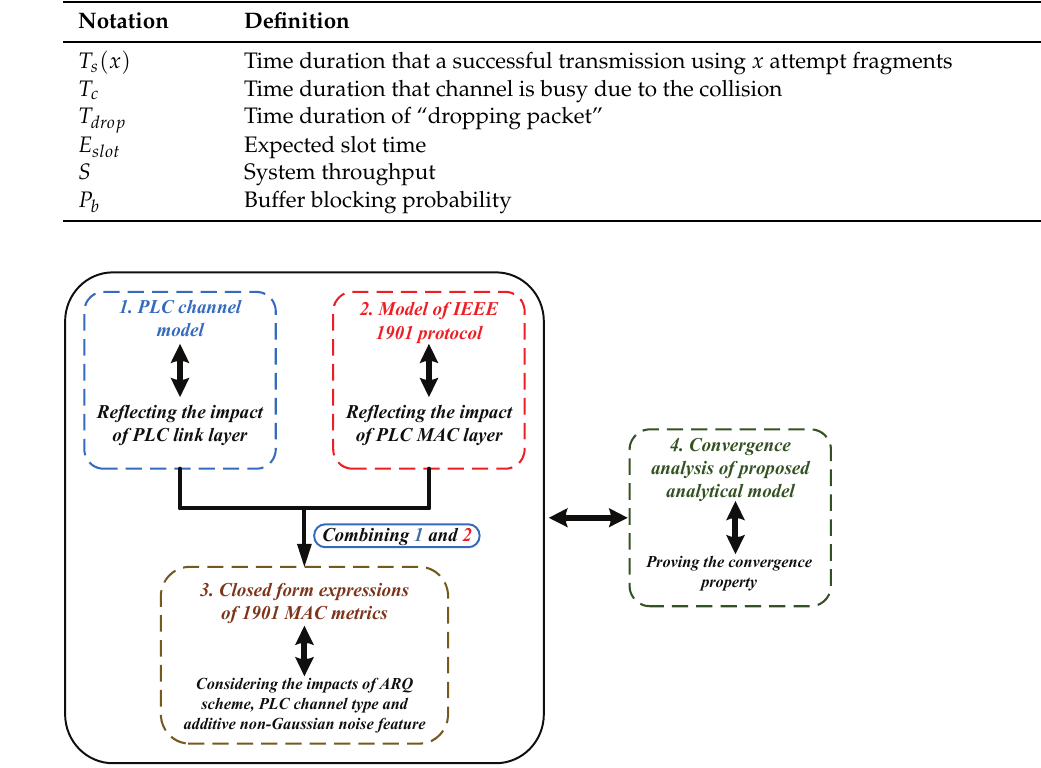
Figure 2. Modeling steps of the proposed analytical